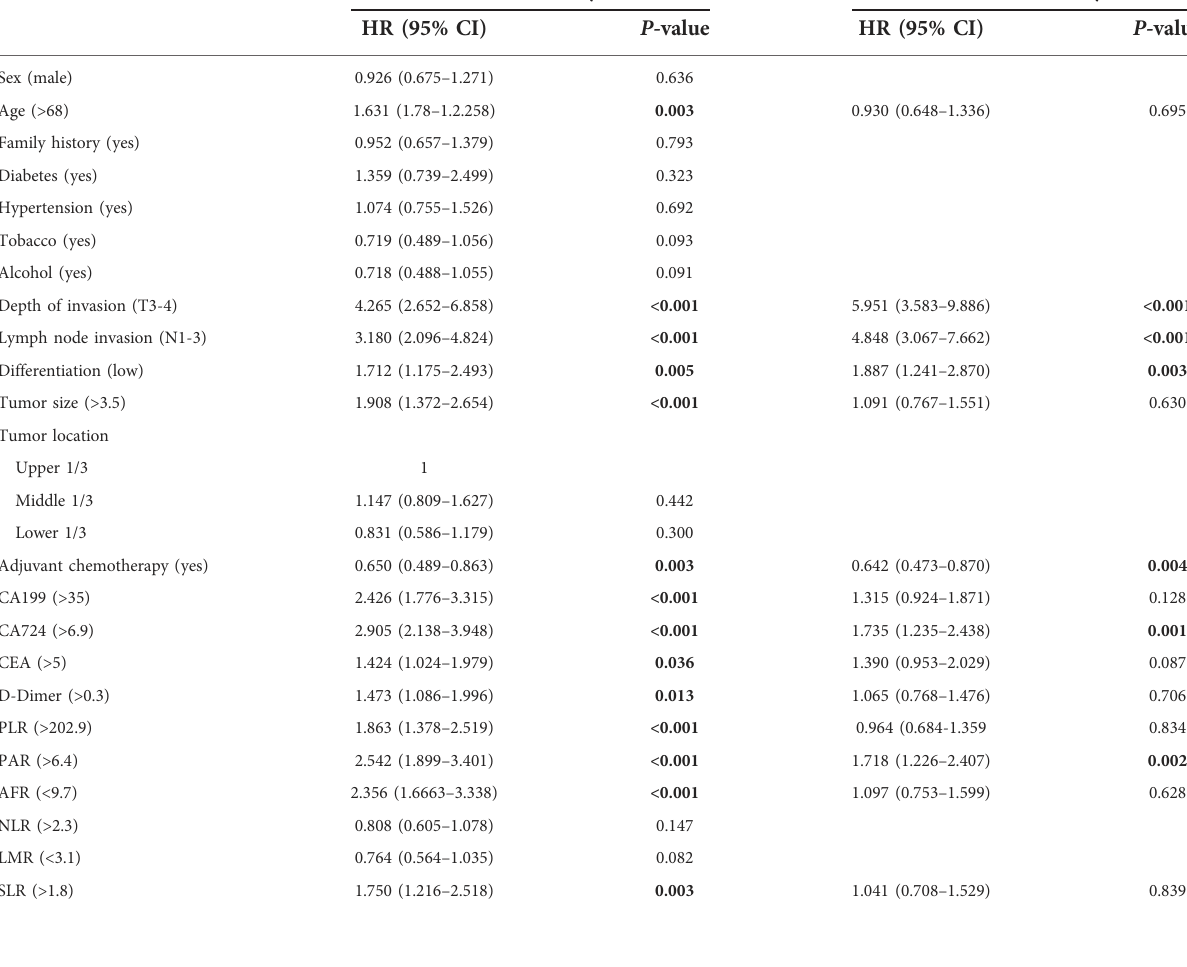
TABLE 3 Univariate and multivariate cox regression analyses of prognostic factors for disease-free survival.